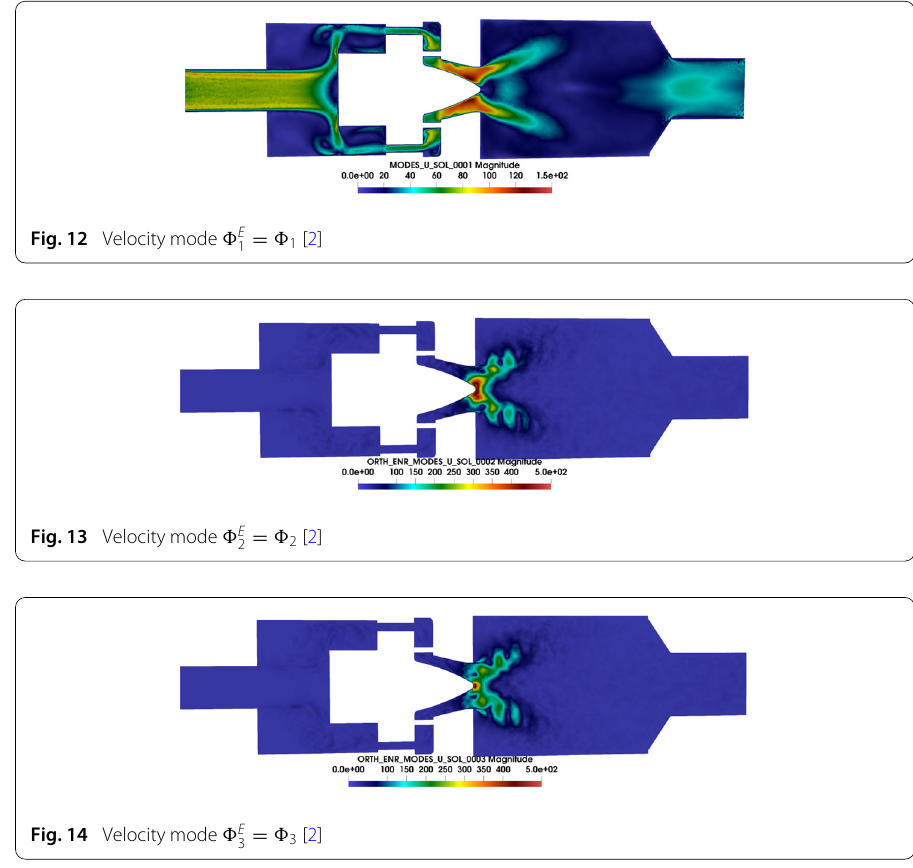
Fig. 14 Velocity mode (cid:3) E